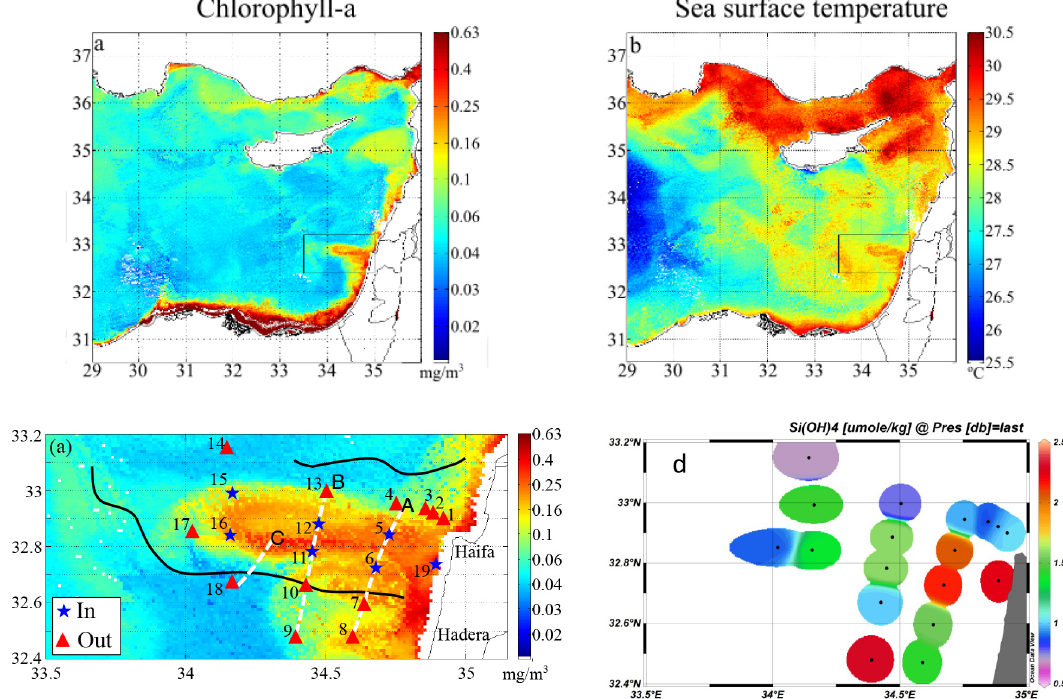
Fig. 20. Satellite images of chlorophyll a (upper panel) and sea surface temperature (middle panel) showing a filament protruding from the Israeli coast, easternmost Levantine Basin, in August 2011. The concentration of silicic acid measured at the surface (lower panel) was higher at the stations inside the filament than outside it. Modified from Efrati et al.